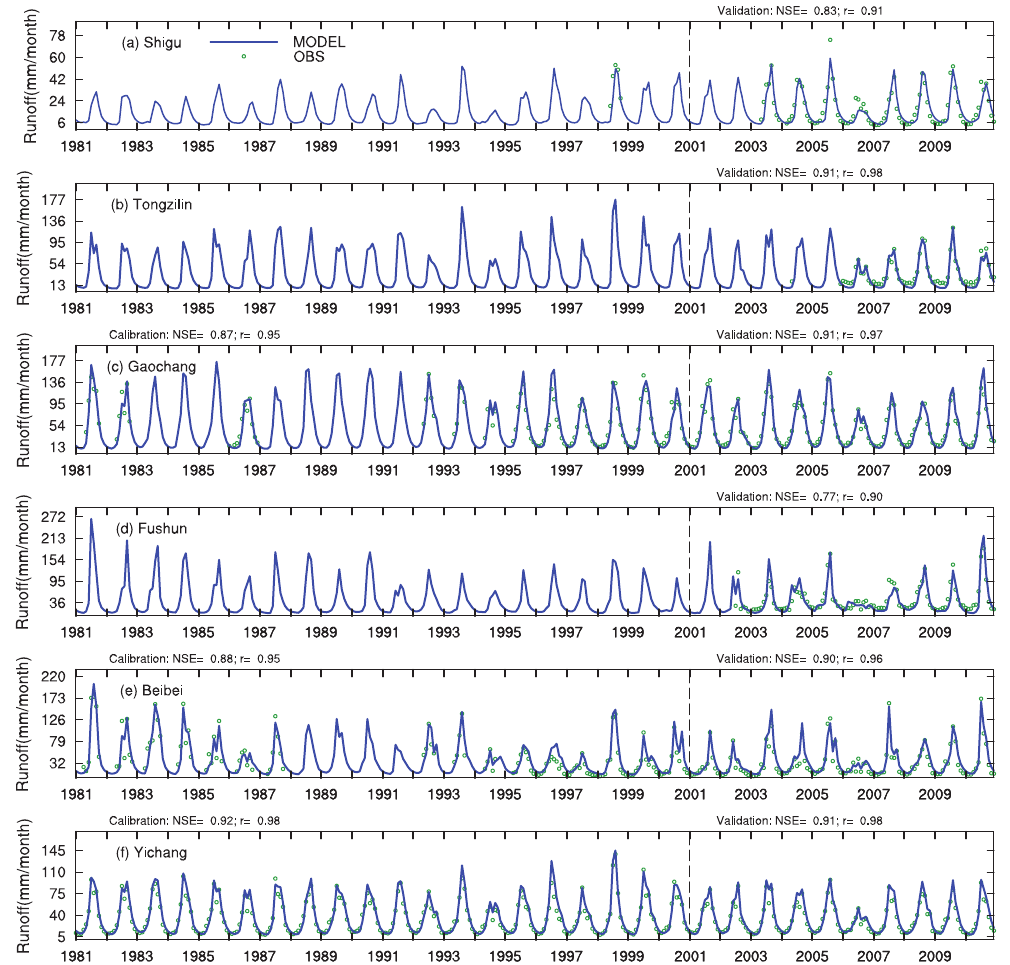
Figure 3. Comparison between modeled and observed runoff at six runoff gauging stations ( a – f ) during the calibration period (1981 to 2000) and validation period (2001 to